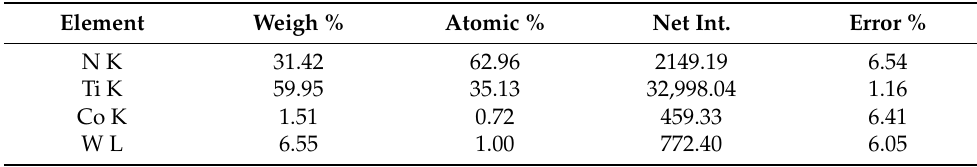
Table 1. The composition of the TiN coating. Element